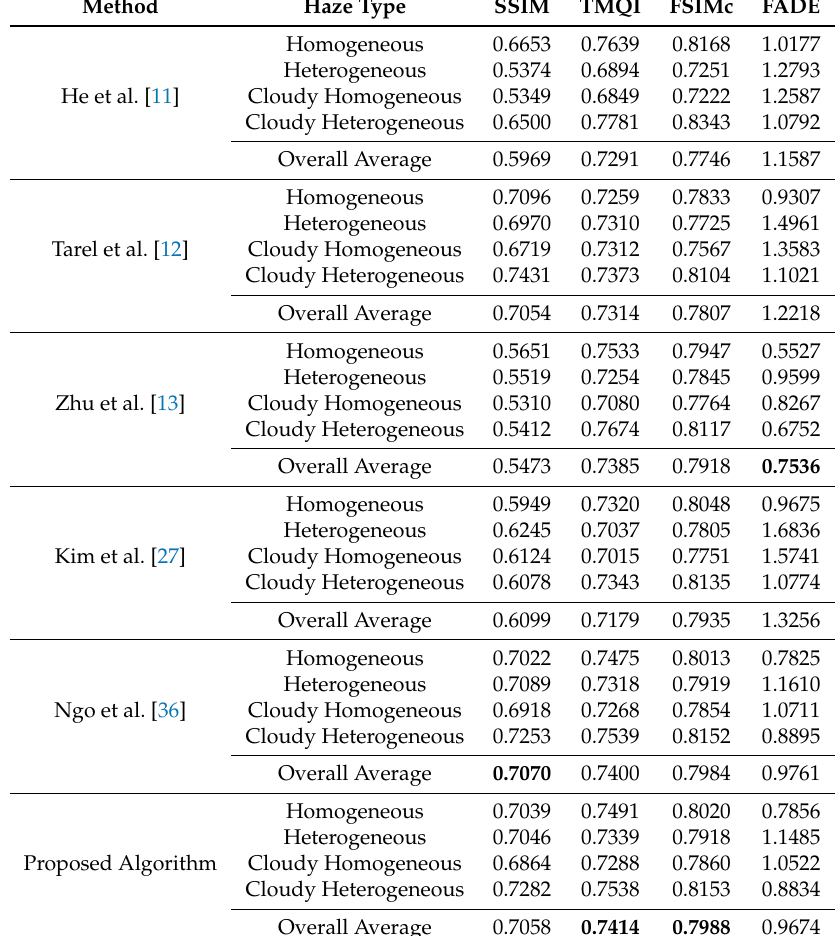
Table 3. Average structural similarity (SSIM), tone-mapped image quality index (TMQI), feature similarity extended to color images (FSIMc), and fog aware density evaluator (FADE) scores on FRIDA2 dataset.